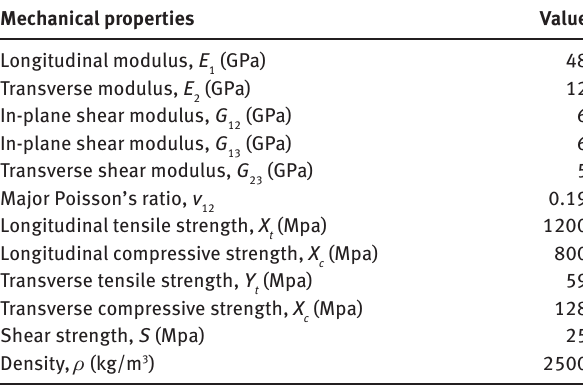
Table 1: Tool geometry and cutting parameters. Parameters